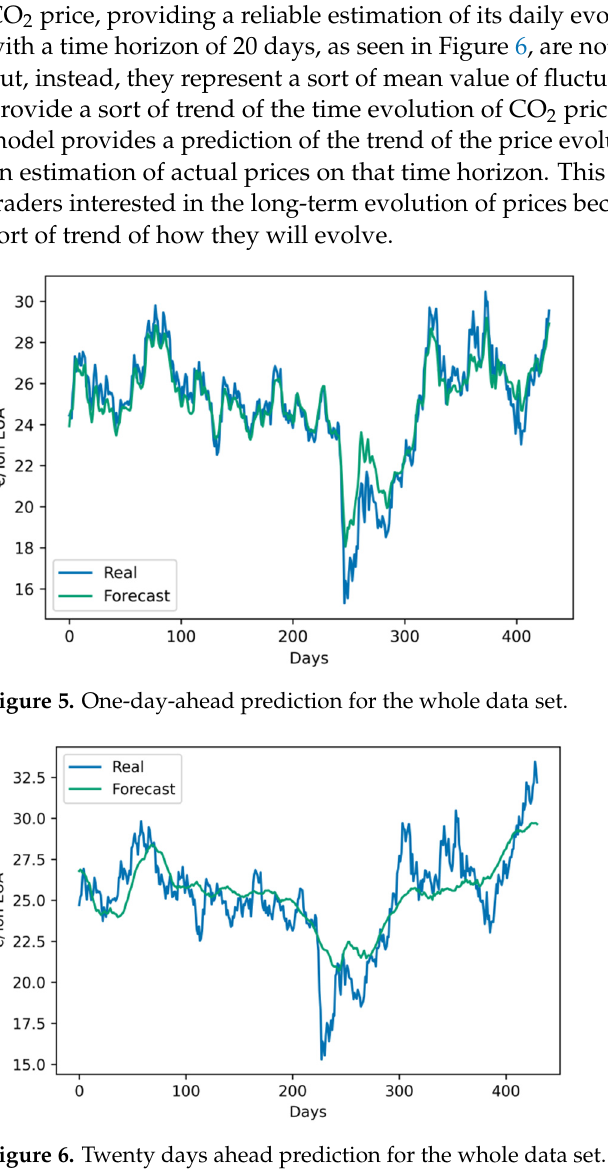
Figure 6. Twenty days ahead prediction for the whole data set.